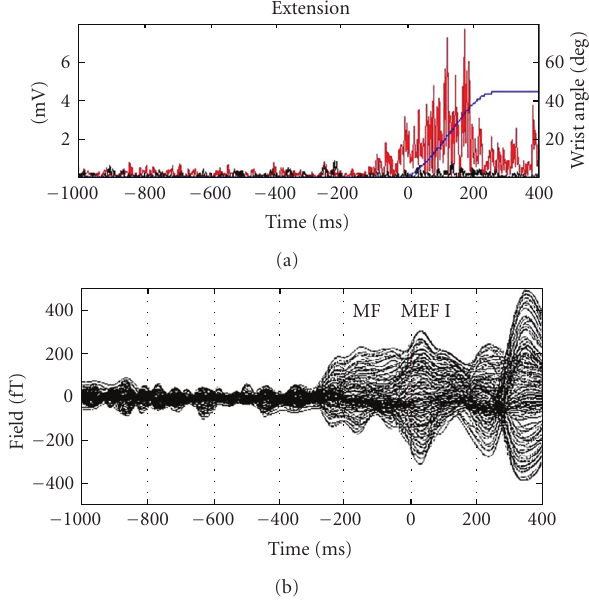
Figure 3: Mean wrist extensions of a typical subject: (a) Time course of electromyography signals in extensor and flexor muscles and wrist angle (one exemplary epoch; red: EMG signal of the extensor carpi ulnaris muscle; black: EMG signal of the flexor carpi ulnaris muscle; blue: wrist angle). (b) Overlay of magne- toencephalographic signals (148 channels) averaged with respect to movement onset. Time 0 indicates the extension M-onset.